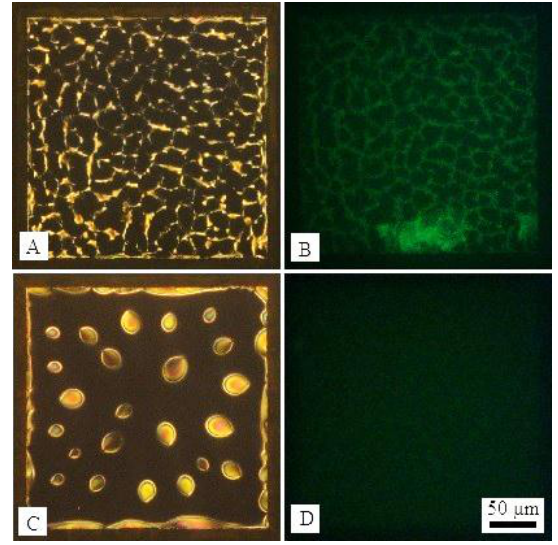
Figure 3. ( A ) Optical images (crossed polars) and ( B ) corresponding fluorescence micrographs of LC-aqueous interface decorated with DNA-lipids and L -DLPC, and dyed by SYBR Green; ( C ) Optical images and ( D ) corresponding fluorescence micrographs after the introduction of 20 μM c-DNA of DNA-lipids for 3 min in ( A ).